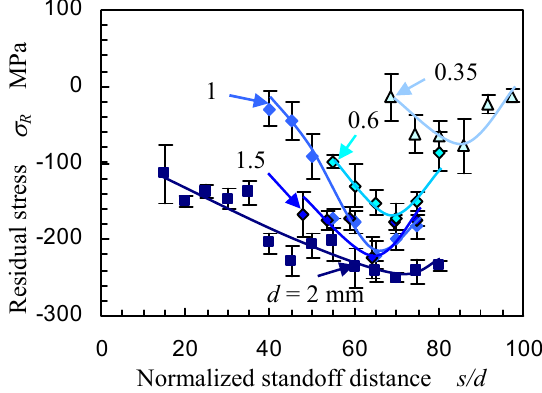
Fig. 8 Residual stress as a function of standoff distance ( p = 30 MPa, p = 0.1 MPa, σ = 0.003, t 1 2